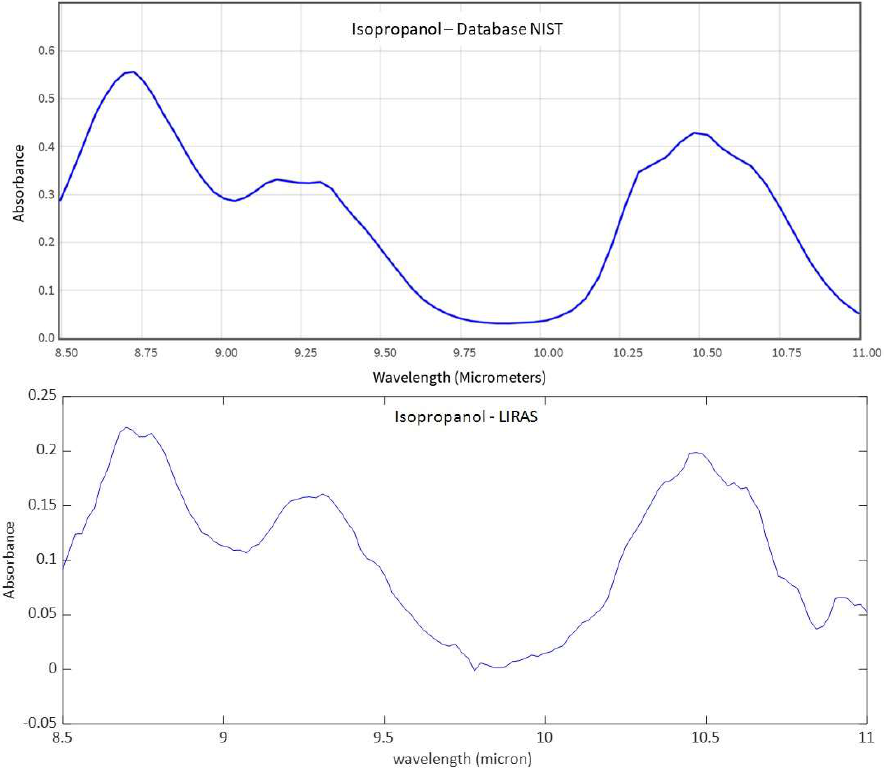
Figure 13. IR comparison between the reference IR absorption spectrum of isopropanol from the NIST database and the spectrum measured by the LIRAS sensor.